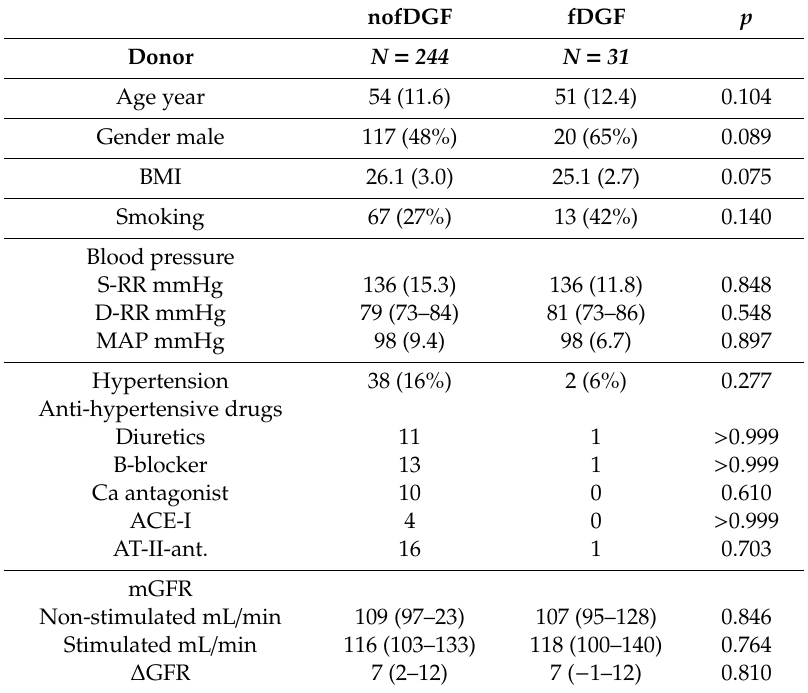
Table 1. Donor and recipient demographics. Data given as number (%), mean (SD), or median